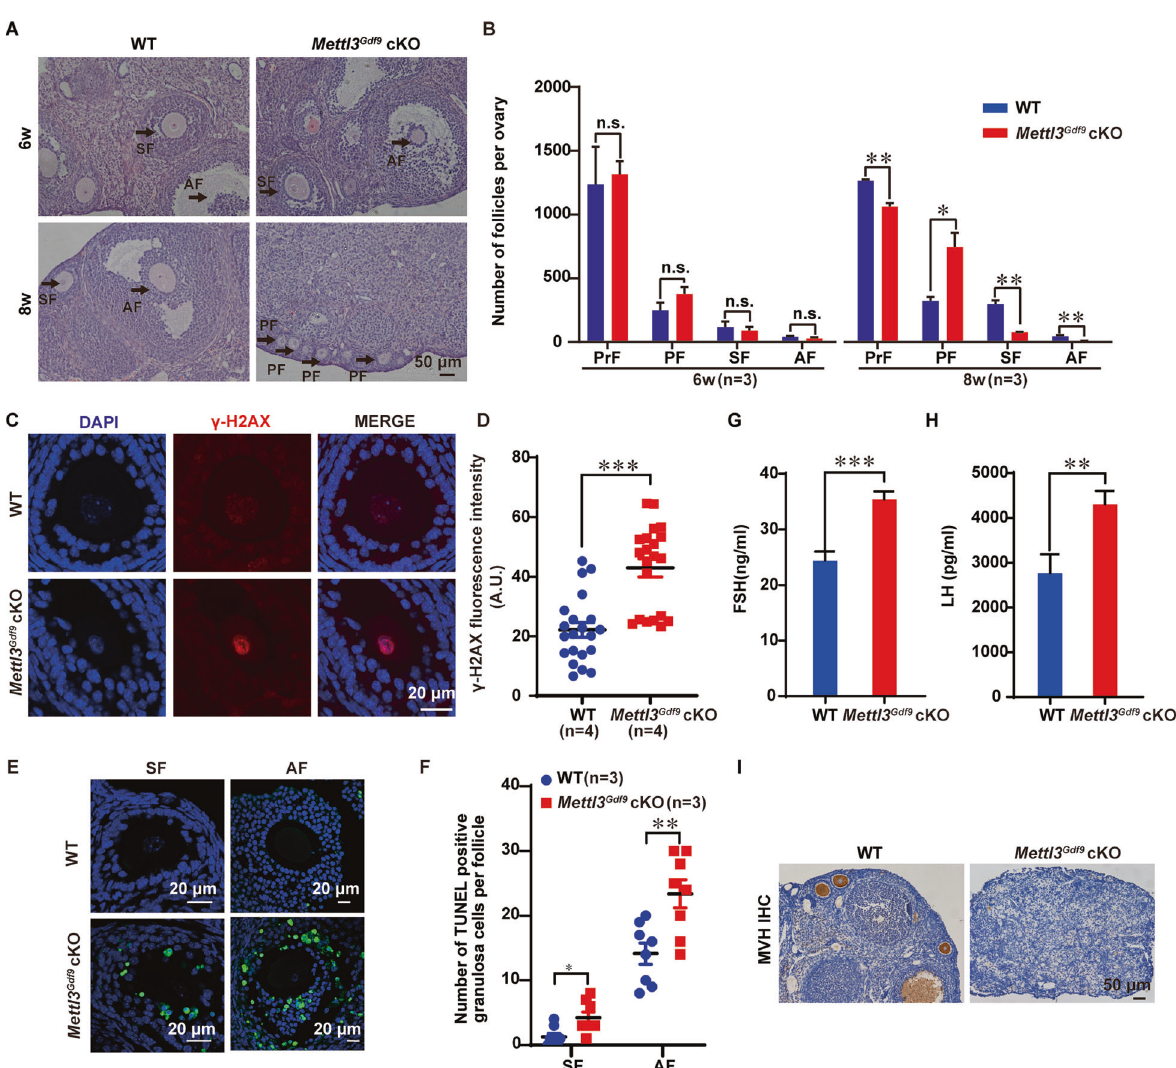
Fig. 2 Mettl3 Gdf9 cKO mice display follicle developmental defects and POF. A Representative ovarian histology of 6-week-old, 8-week-old WT, and Mettl3 Gdf9 cKO mice. The primary, secondary, and antral (indicated with PF, SF, and AF, respectively) follicle stages are indicated by the black arrow. Scale bar, 50 μ m. B Quanti fi cation of the numbers of different types of follicles in ovaries from 6-week-old, 8-week-old WT, and Mettl3 Gdf9 cKO mice. Primordial, primary, secondary, and antral follicles (indicated with PrF, PF, SF, and AF, respectively) were counted. n.s., p > 0.05; * p < 0.05; ** p < 0.01 by two-tailed Student ’ s t -test. Data represent the mean ± SEM ( n = 3). C Confocal immuno fl uorescence staining with γ H2AX antibody (red) and DAPI (blue) in ovary sections from 6-week-old WT and Mettl3 Gdf9 cKO mouse ovaries. Scale bars, 20 μ m. D Graph showing the quanti fi cation of γ -H2AX staining. *** p < 0.001 by two-tailed Student ’ s t -test. Data represent the mean ± SEM ( n = 4). E Detection of apoptosis in granulosa cells by TUNEL kit performed in paraf fi n sections at different stages of follicle development of 6-week-old WT and Mettl3 Gdf9 cKO mouse ovaries. Secondary and antral follicles (indicated with SF and AF, respectively) were counted. Scale bars, 20 μ m. F Graph showing the quanti fi cation of the number of TUNEL positive granulosa cells at different follicle stages. * p < 0.05; ** p < 0.01 by two-tailed Student ’ s t -test. Data represent the mean ± SEM ( n = 3). G , H FSH and LH levels of WT and Mettl3 Gdf9 cKO mice. Serum samples were collected from female mice of both genotypes (12 to 20 weeks old) and were killed for measurement of FSH and LH levels. FSH: WT, n = 5; Mettl3 Gdf9 cKO, n = 9. LH: WT, n = 8; Mettl3 Gdf9 cKO, n = 9. ** p < 0.01; *** p < 0.001 by two-tailed Student ’ s t -test. Data represent the mean ± SEM. I Immunohistochemistry with MVH antibody in ovary sections from 24-week-old WT and Mettl3 Gdf9 cKO mice. Scale bar, 50 μ